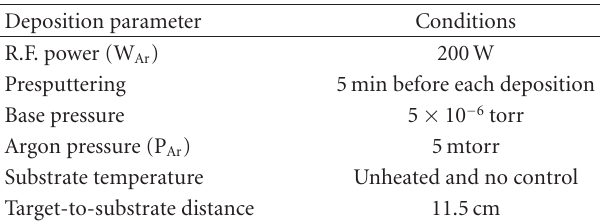
Table 1: RF sputtering conditions for deposition of ZnO films from ceramic